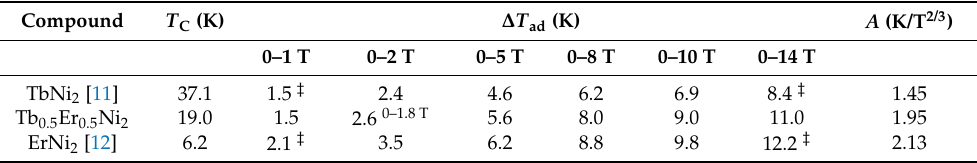
Table 3. Experimental data characterizing the adiabatic temperature change, ∆ T ad , due to MCE caused by the magnetic field change, µ 0 ∆ H , for the parent TbNi 2 and ErNi 2 binary compounds and for the Tb 0.5 Er 0.5 Ni 2 compound. A is the coefficient from equation ∆ T ad = A ( µ 0 ∆ H ) 2/3 . The data were obtained by direct measurements of ∆ T ad during the field change, µ 0 ∆ H , achieved by using the extraction method in a Bitter magnet. The values of ∆ T ad marked with ‡ symbol are estimated by the extrapolation of the ∆ T ad = A ( µ 0 ∆ H ) 2/3 relation.